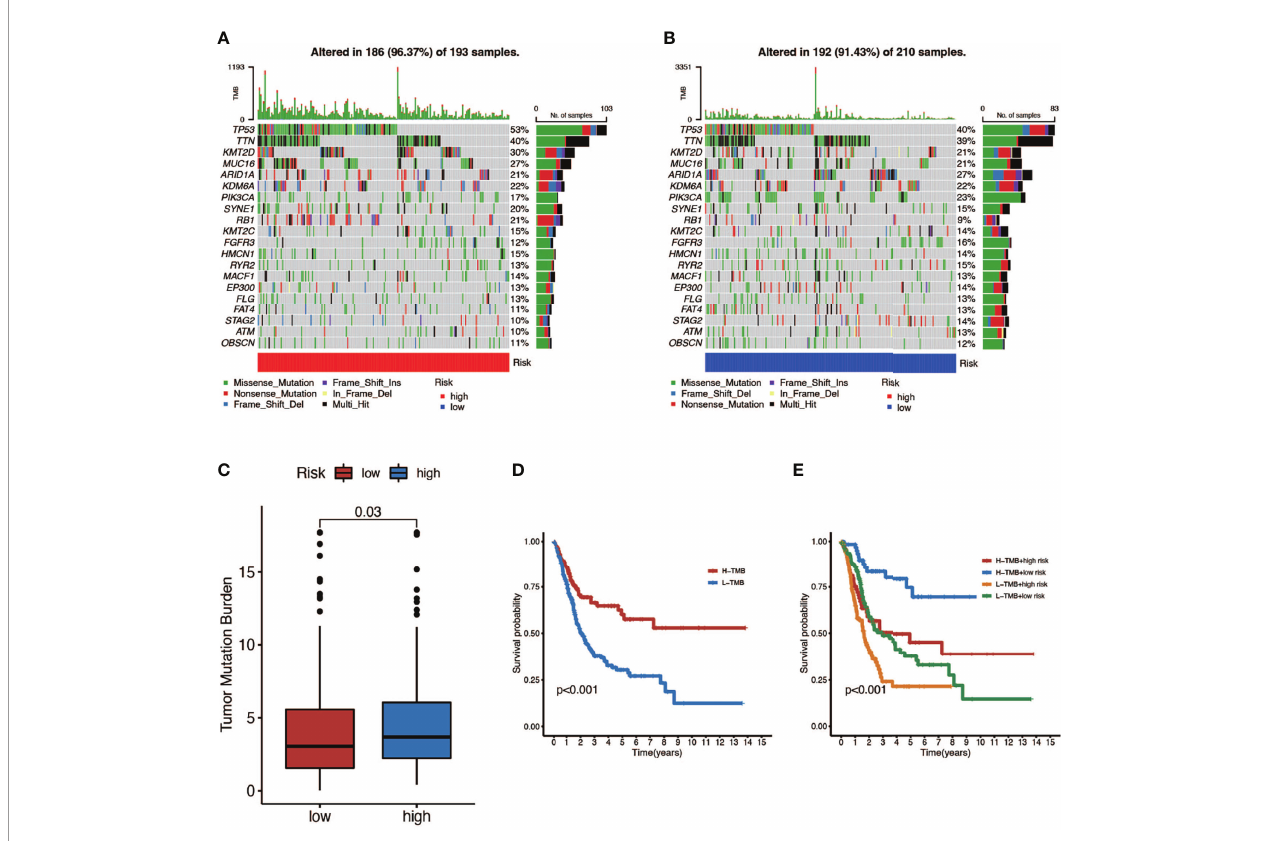
FIGURE 5 | The relationship between tumor mutation burden (TMB) and risk score. (A, B) Mutation spectrum of high-risk (left) and low-risk (right) patients. (C) Comparison of TMB between patients in the high- and low-risk score groups. (D) Survival analyses for low- and high-TMB patient groups in TCGA-BLCA cohort using Kaplan – Meier curves (P < 0.001, log-rank test). (E) Survival analyses for four groups grouped according to TMB and risk score in TCGA-BLCA cohort using Kaplan – Meier curves. The high-TMB and low-risk score groups showed signi fi cantly better overall survival than the other three groups (P < 0.001, log-rank